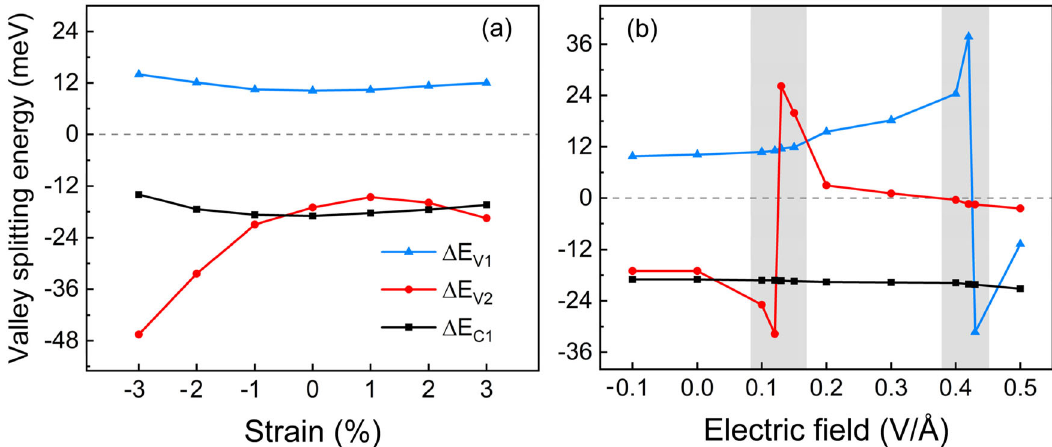
Fig. 5 Valley splittings of H M stacked MoSe 2 /VSe 2 under external fi eld. The valley splittings Δ E V1 , Δ E V2 , and Δ E C1 as a function of ( a ) in- Se plane biaxial strain and ( b ) electric fi eld applied perpendicular to the heterostructure. All the calculations were carried out using HSE ( α = 0.1, μ = 0.2 Å − 1 )